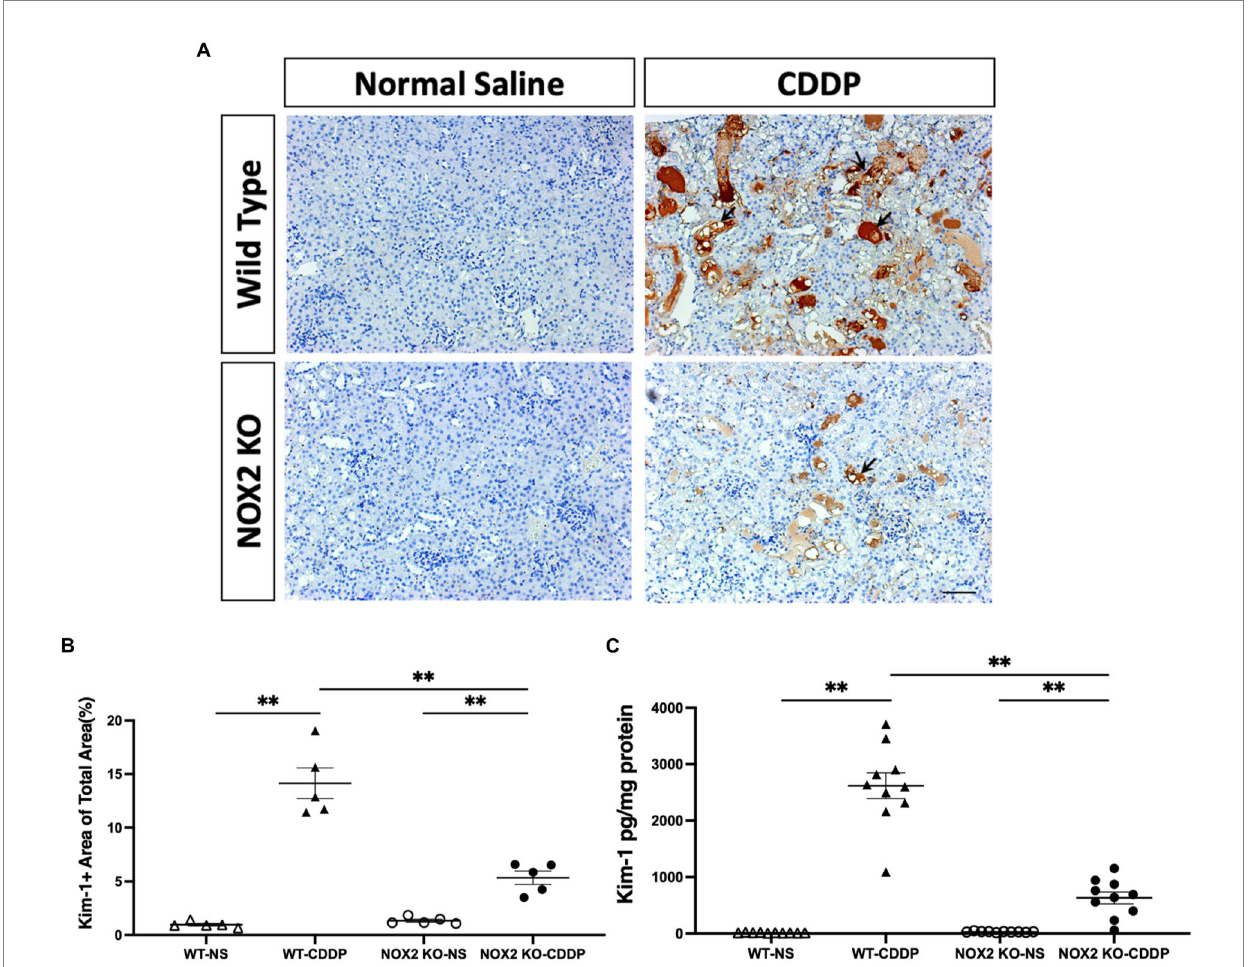
FIGURE 4 Mice with NOX2 deletion had decreased Kim-1 levels in cisplatin-induced AKI. (A,B) Kim-1, a biomarker of renal tubular injury, was overexpressed and accumulated in the WT CDDP group’s peritubular area (black arrow). Immunohistochemical analysis indicated that the area of Kim-1 was greater after cisplatin and reduced in the NOX2 KO mice. (C) NOX2 deletion reduced Kim-1 protein levels in cisplatin-induced AKI, as indicated by the Luminex assay. Data represent the mean ± standard error of five mice per group. Scale bar = 100 μ M. The experiment was repeated twice with similar